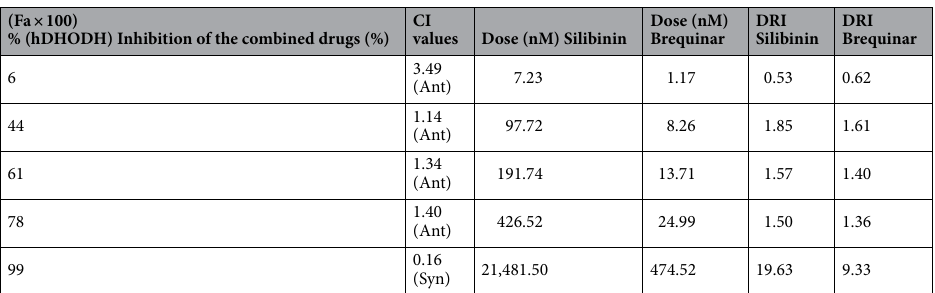
Table 6. Fractional inhibition of hDHODH, combination index values (CI) and DRI values of silibinin and brequinar in combination at several effect levels. Fa signifies fraction affected. CI < 1, = 1, and > 1 indicate synergism (Syn), additive effect (Add), and antagonism (Ant), respectively.DRI > 1 indicates favourable dose reduction (in fold) for the drug in combination.